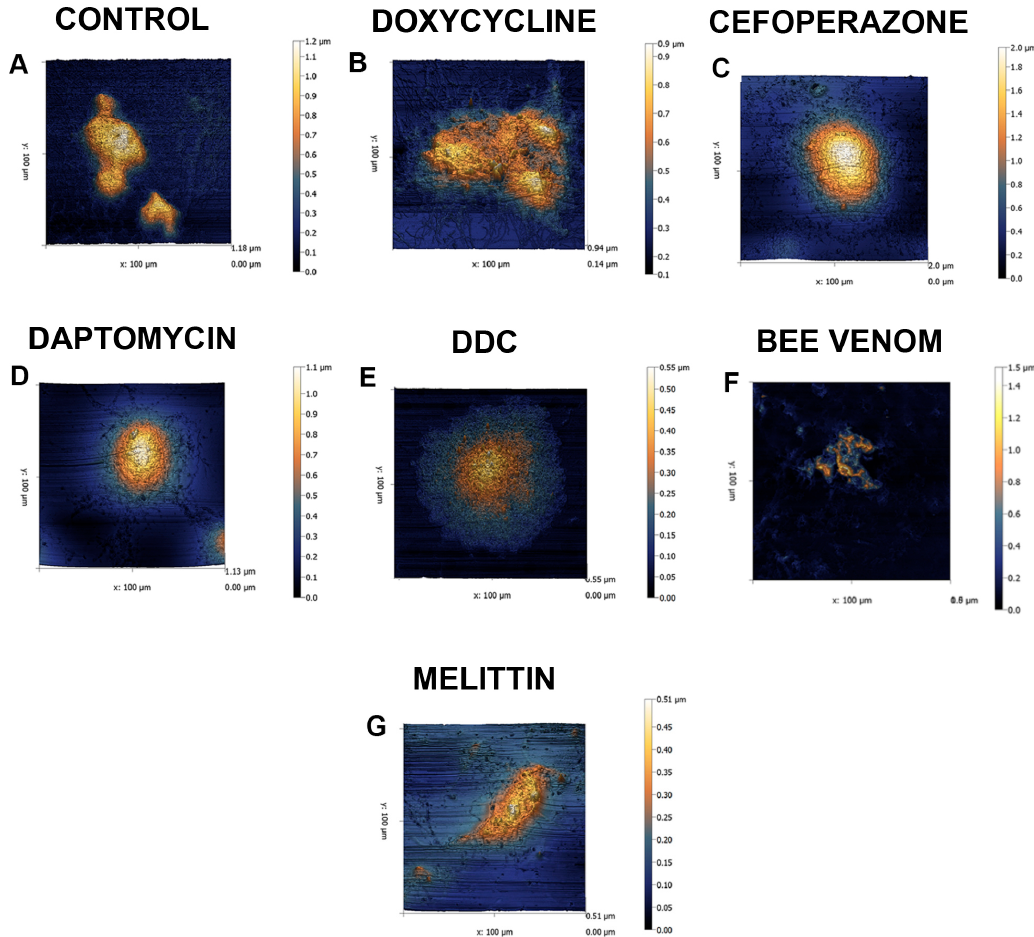
Figure 7. Representative atomic force microscopy images showing the ultrastructural details of Borrelia biofilm before and after treatment with antimicrobial agents. The preparations of B. burgdorferi strain B31 biofilms on chamber slides are described in Methods section. All biofilms were scanned at 0.4 Hz using contact mode and the individual Z ranges (height) are indicated next to each panel by means of a scale. The images were scanned using the Nanosurf Easyscan 2 software and the images were processed using Gwyddion software. Scale bar located on the side of corresponding AFM scan indicate the height changes of the topography of the biofilm. Darker colors (black and blue) indicate the surface of the slide while lighter colors (yellow to white) indicate high points of attached biofilms. Attached Borrelia biofilms treated with Panel ( A ) PBS (control), Panel ( B ) Doxycycline (10 µ g/mL), Panel ( C ) Cefoperazone (10 µ g/mL), Panel ( D ) Daptomycin (10 µ g/mL), Panel ( E ) Three antibiotic combination: Doxycycline + Daptomycin + Cefoperazone (DCC, 10 µ g/mL/each), Panel ( F ) Bee venom (400 μ g/mL) and Panel ( G ) Melittin (200 μ g/mL).